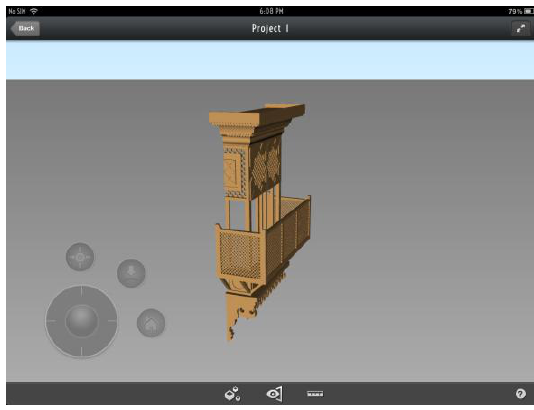
Figure 8. Roshan in BIM 360 Glue.